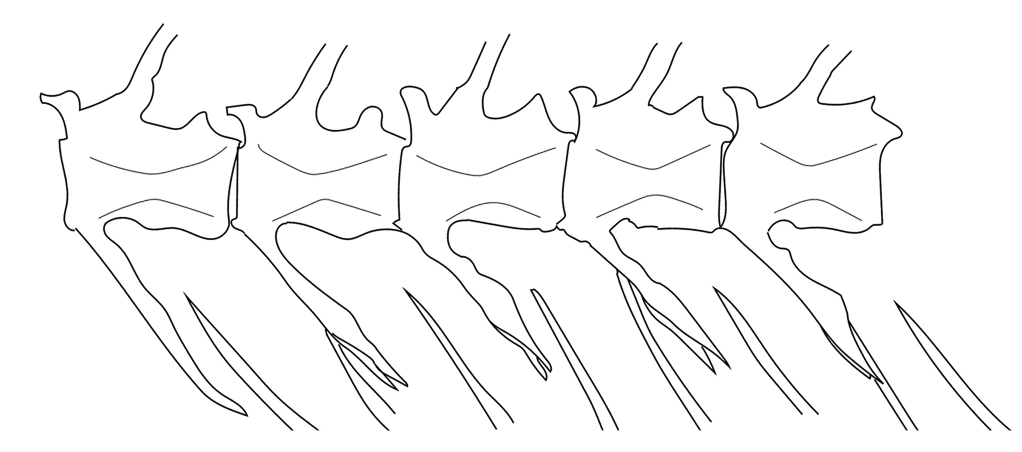
FIGURE 5 | Lateral view of bifid hemal spines of vertebrae 27 to 31, located dorsally to anal-fin pterygiophores. Phenacorhamdia suia , paratype, LBP 15886 (1 c&s), 51.3 mm